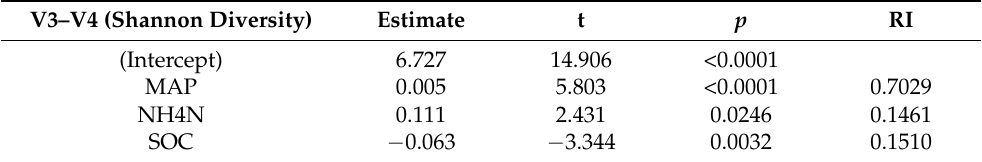
Table 1. The impacts of environmental factors on the soil bacterial diversity of sequences obtained using the 338f/806r primer set targeting the V3–V4